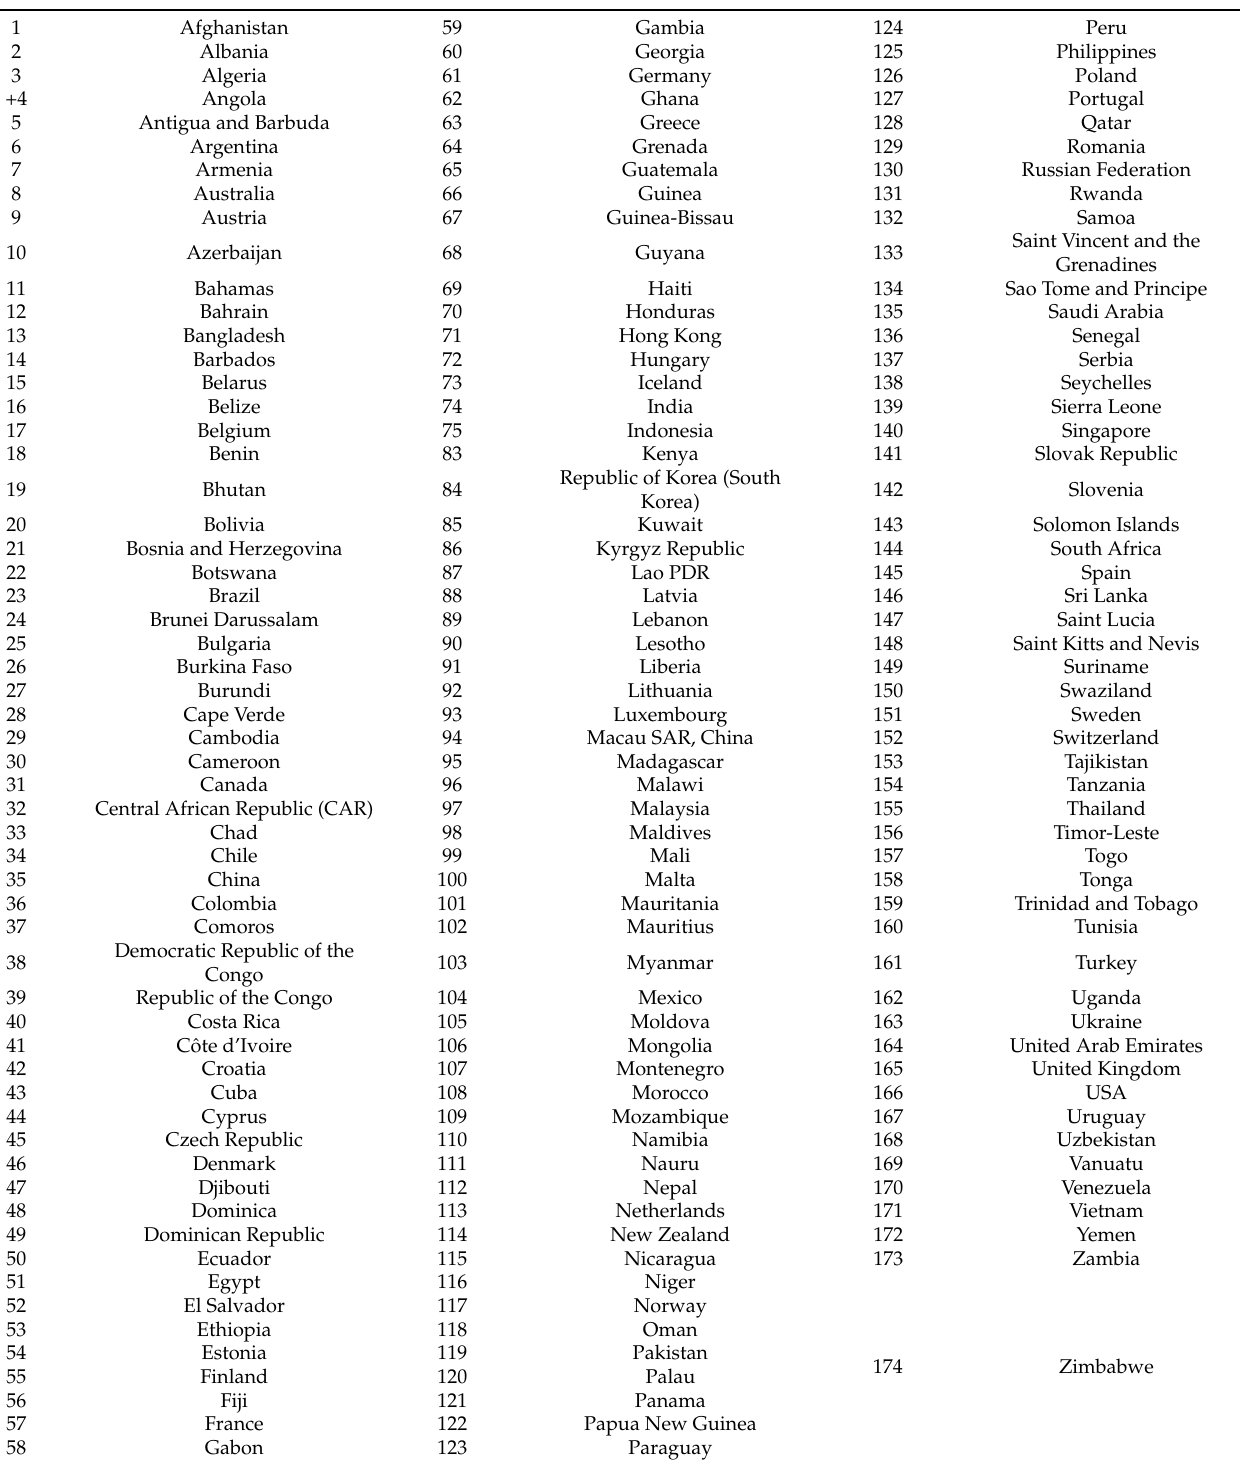
Table A1. Numbering of countries according to UNDP